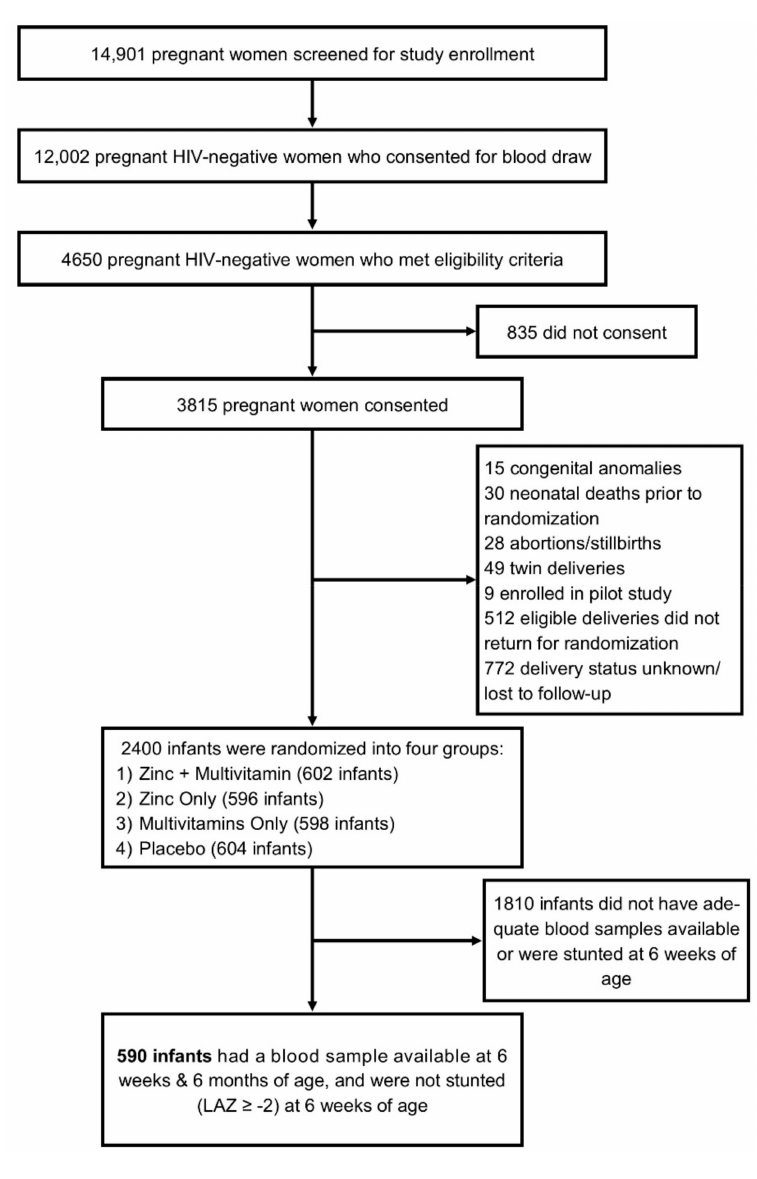
Figure 1. Flowchart demonstrating the selection criteria for our patient